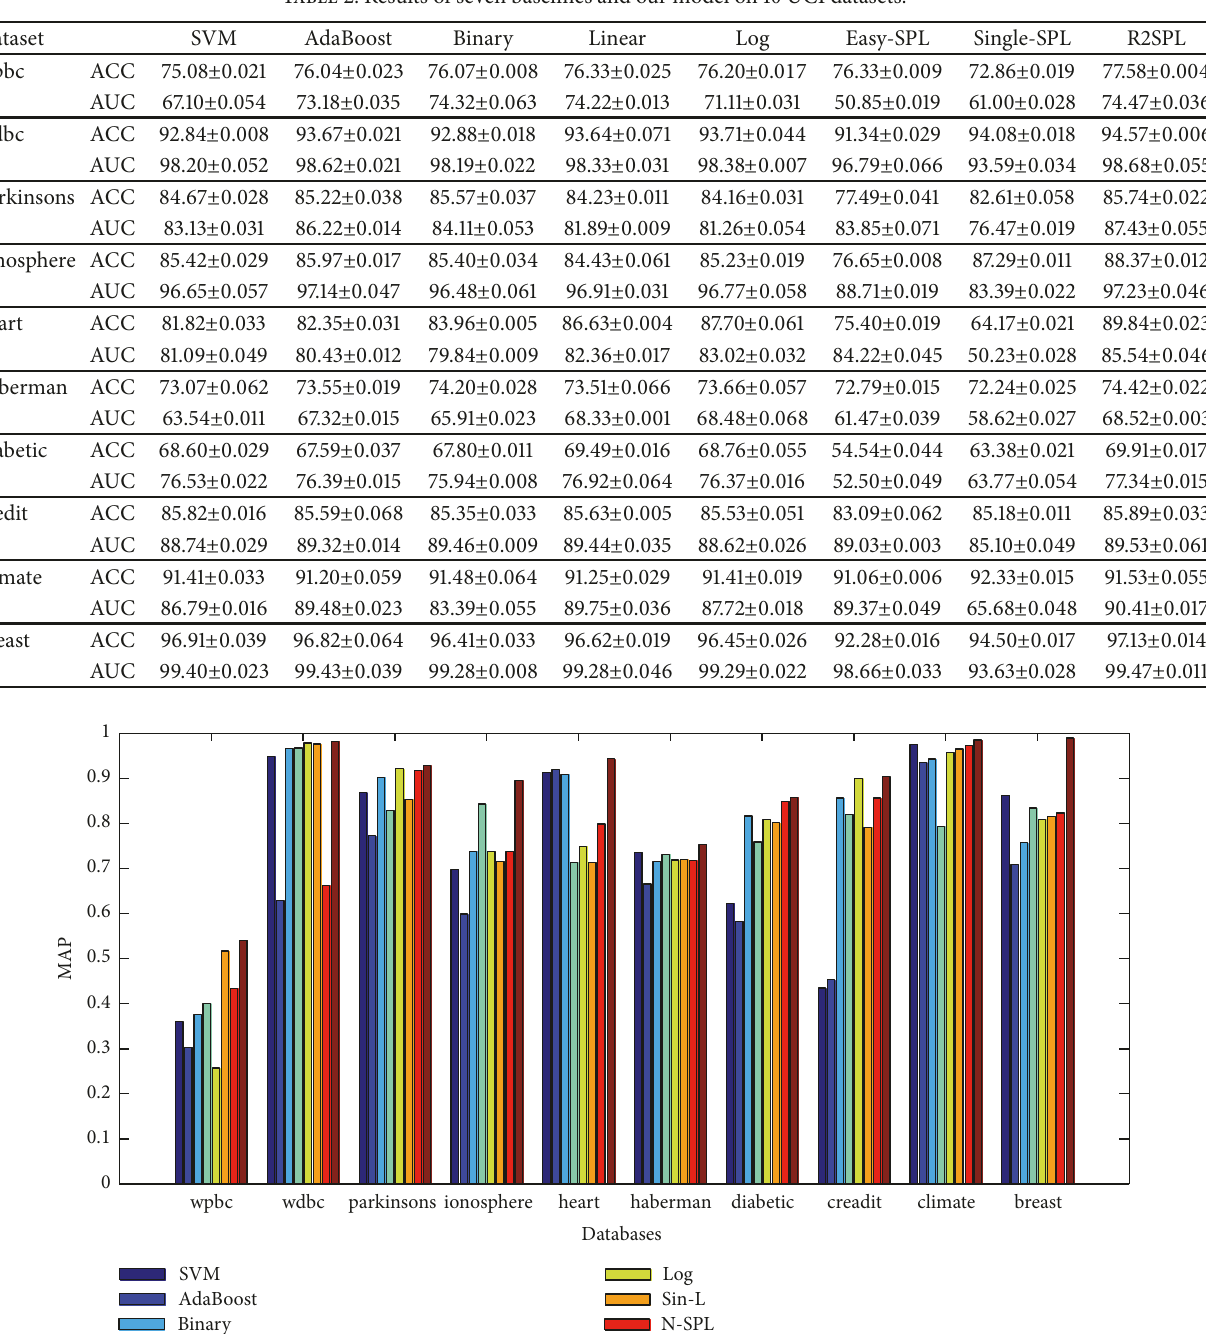
Figure 4: The classification results of state-of-art methods and our model on ten